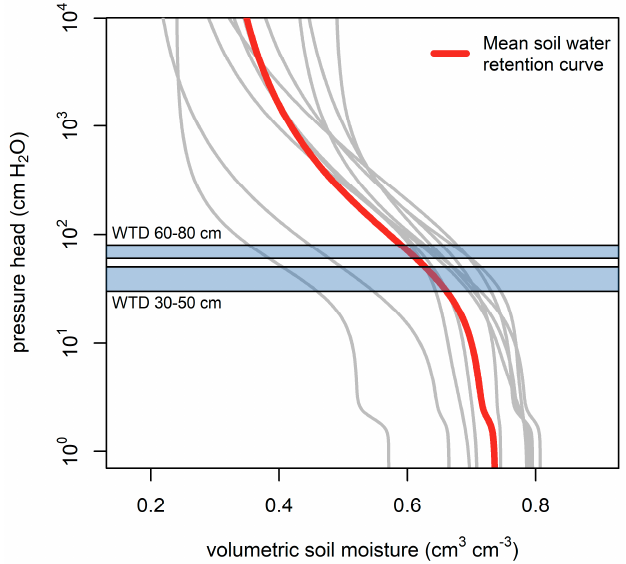
Figure 9. Soil water retention curves from ten different study sites. Mean soil water retention curve is obtained by averaging volumetric soil moisture at the same values of the pressure head. Rectangles (light blue) symbolize surface moisture ranges corresponding to two exemplary WTD ranges of 20 cm and assuming hydrostatic equilibrium conditions.